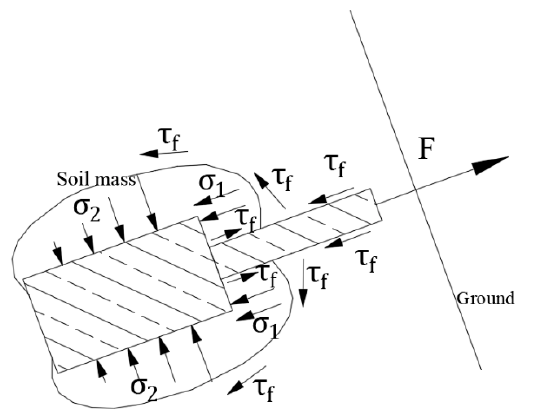
Figure 3. Strengthening effect model of the end resistance to side